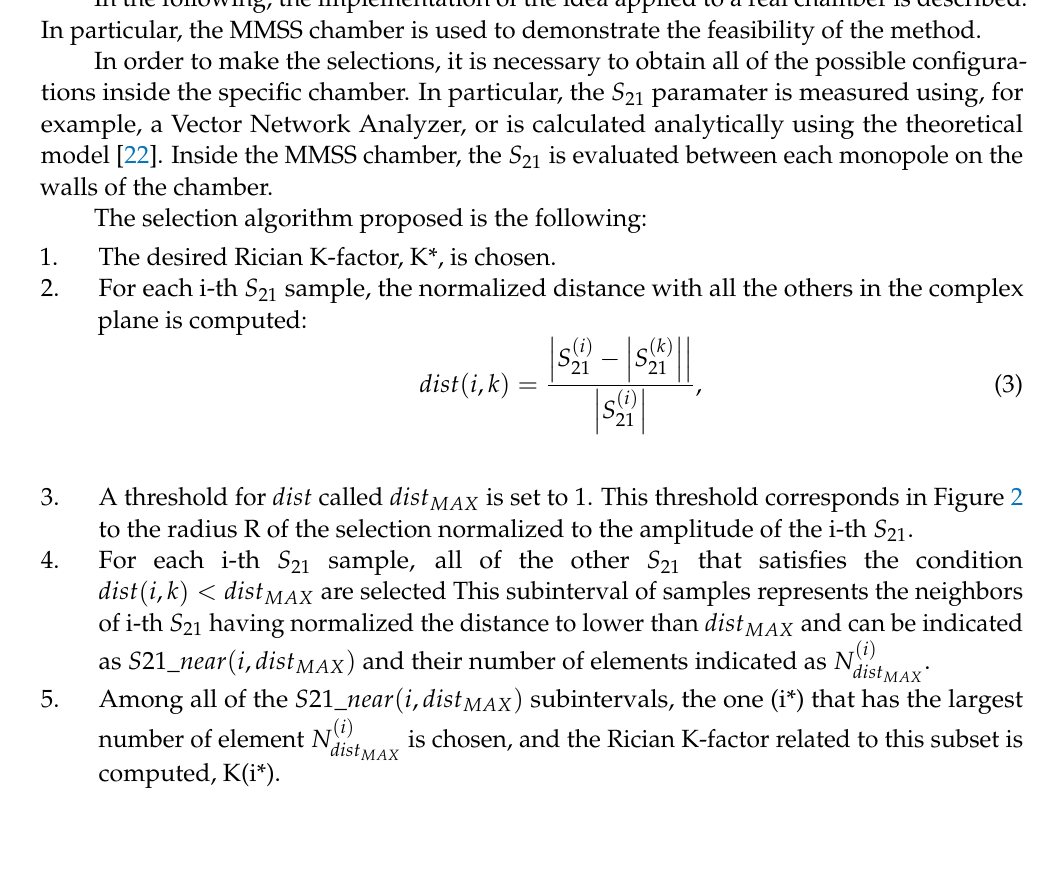
Figure 2. Scatter plot of the S 21 in an ideal reverberation chamber. The blue point represents all of the possible configurations of the field. The yellow, orange and purple points represent the selected configurations for different values of R and C, giving a different value of K-factor.